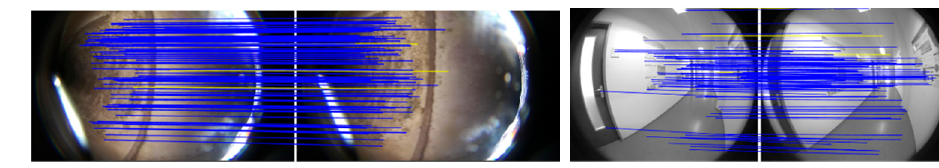
Figure 7. Examples of the matching results. ( a – e ) show the results of the matching methods. The left column shows the results on a pipeline image pair, and the right column shows the results on a TUM image pair. The blue lines indicate correct correspondences, and the yellow lines indicate outliers. For good visualization, only parts of the correspondences are displayed. (P represents the precision, and R represents the recall).